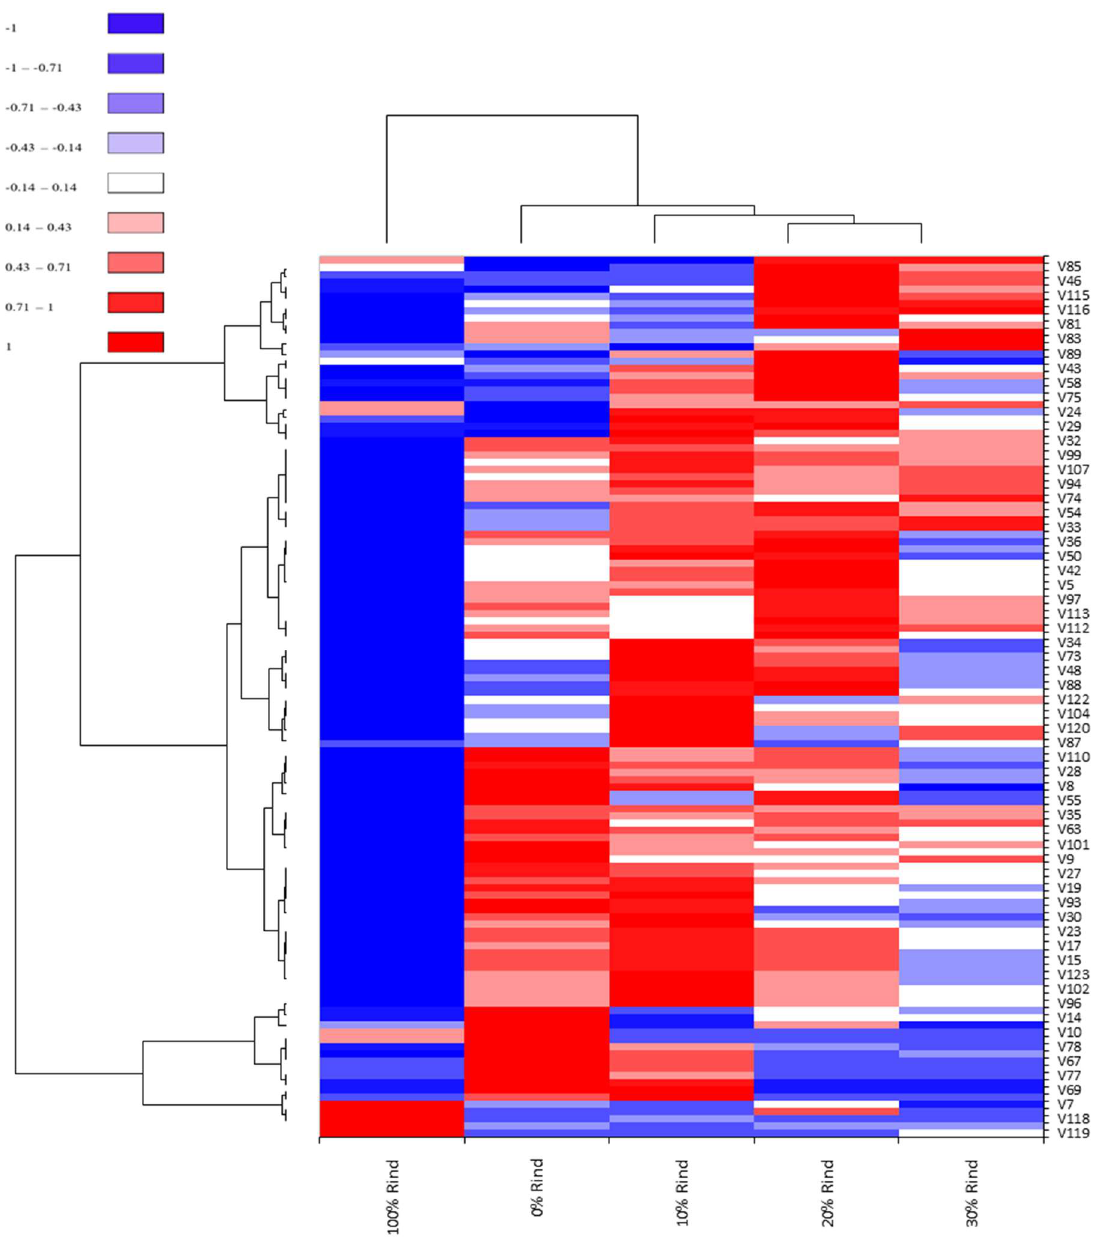
Figure 4. Heat map of 61 selected volatiles (peak area, filtration interquartile range threshold = 0.01) in watermelon rind, flesh, and rind-flesh blends. V: volatiles, which could be found in Table S1.